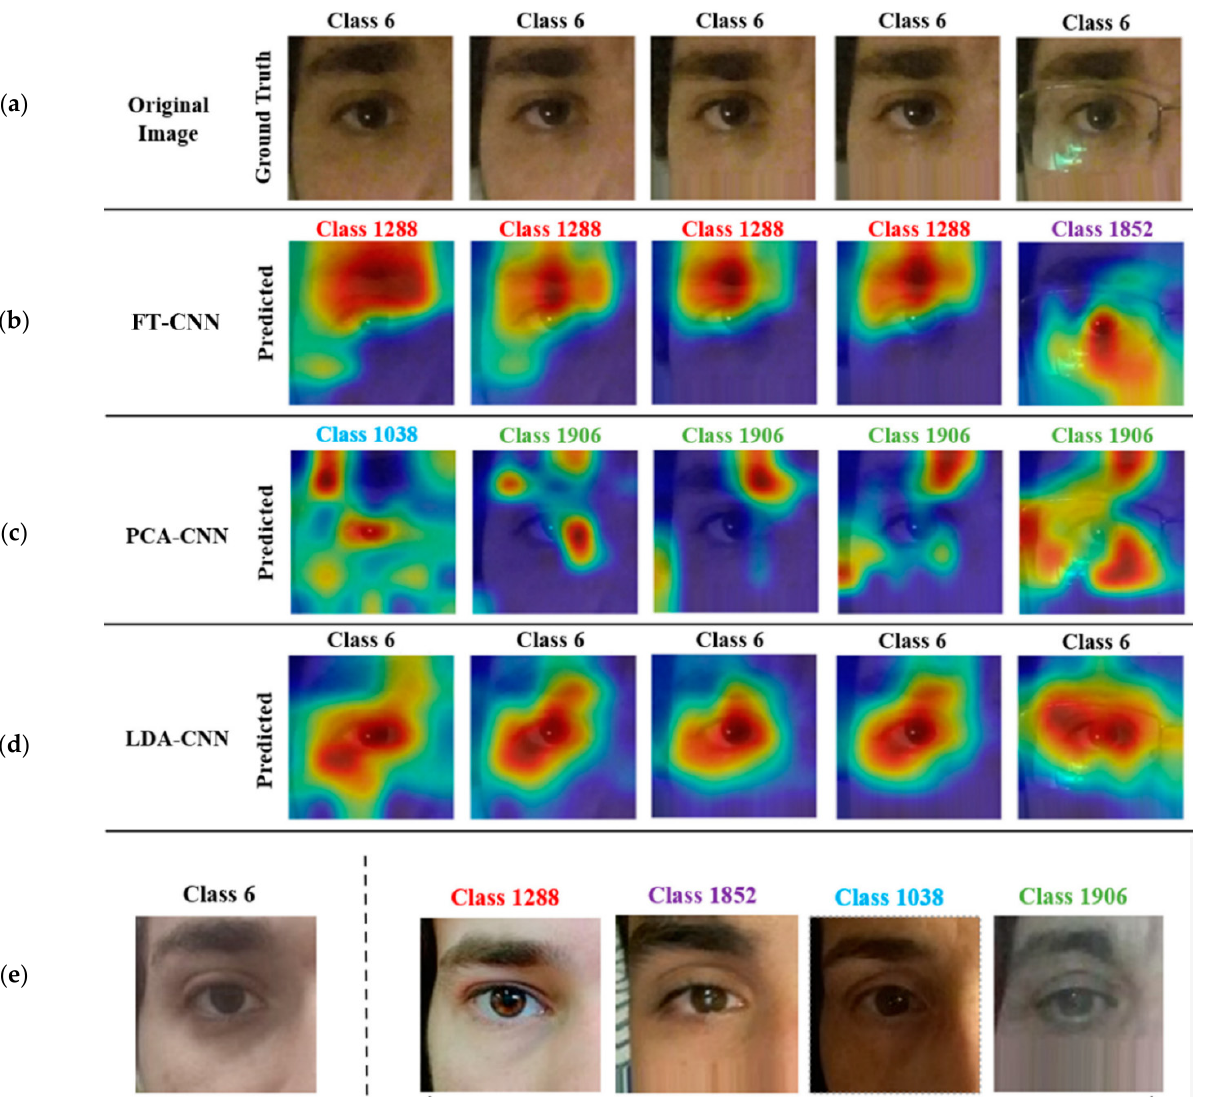
Figure 15. A comparison of the performance and the Grad-CAM explanations for the deep features of ( b ) FT-CNN, ( c ) PCA-CNN and ( d ) LDA-CNN (proposed) on predicting the correct class of ( a ) samples of Class 6 from UFPR dataset under within-class variability and ( e ) between-class similarity challenges.